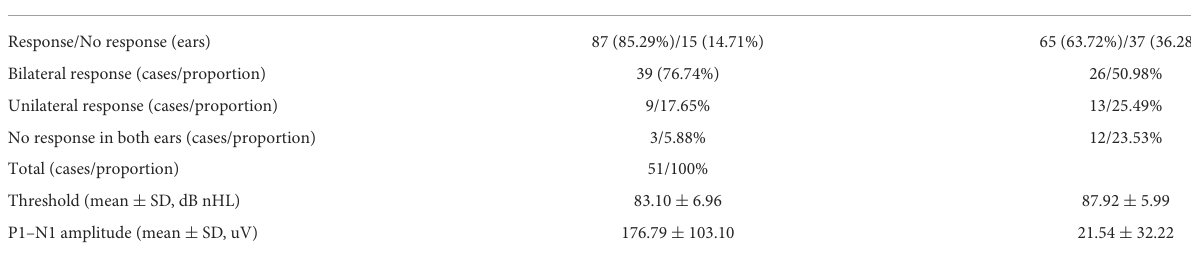
TABLE 1 cVEMP and oVEMP results of all enrolled patients.